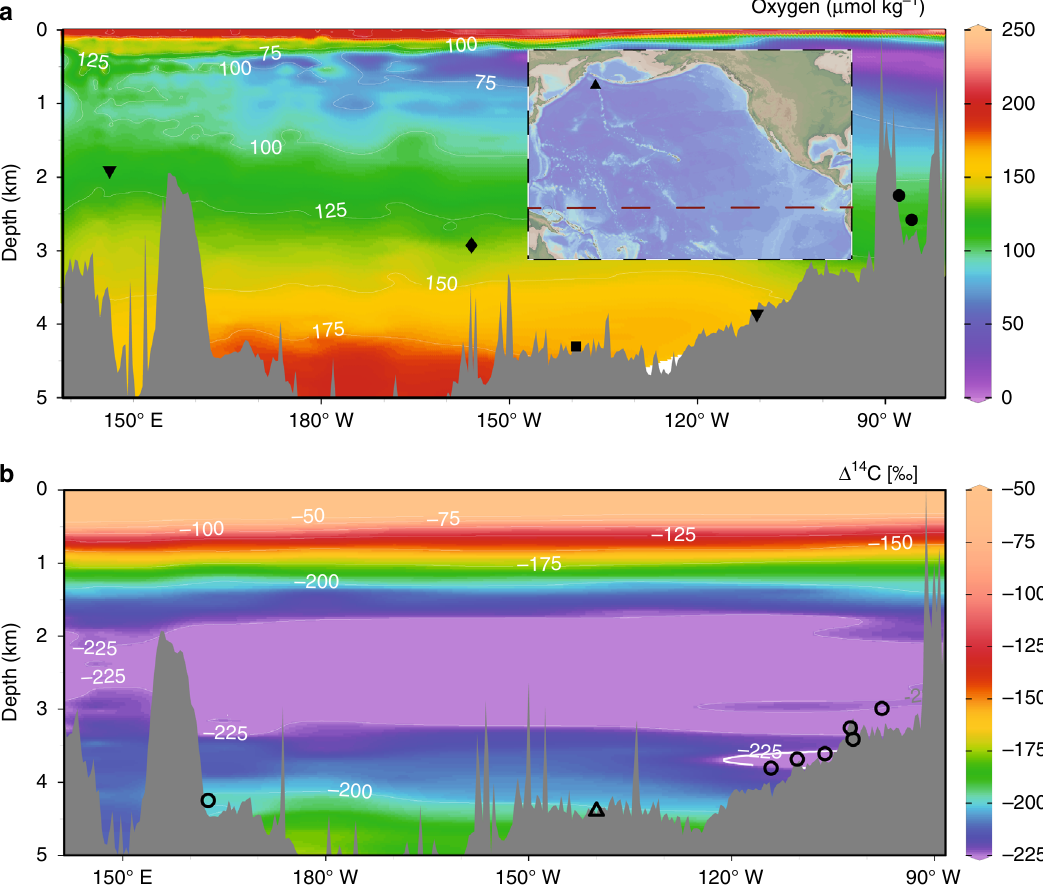
Fig. 1 Maps of study area. Modern oxygen concentrations in μ mol kg − 1 21 with the locations of Paci fi c Ocean records of bottom water oxygen as recorded by aU from ML1208-17PC (this study) (diamond), RC11-238 and RC13-140 13 (dots), TT013-PC72 37, 38 (square), ODP Site 849 and MD97-2138 13, 29 (inverted triangles) and ODP Site 882 12 (triangle) (inset only). Inset shows the approximate position of the oxygen concentration cross section in the context of the Paci fi c Ocean a . b Modern Δ 14 C concentrations 21 with the location of radiocarbon data sets from TTN013-PC18 17 (open triangle) and GS7202-15, PLDS 7G, VNTR01 10 GC, KNR73 3PC, KNR73 4PC, KNR73 6PG, and S67 15FFC 39 (open circles). Note that the other ML1208 core